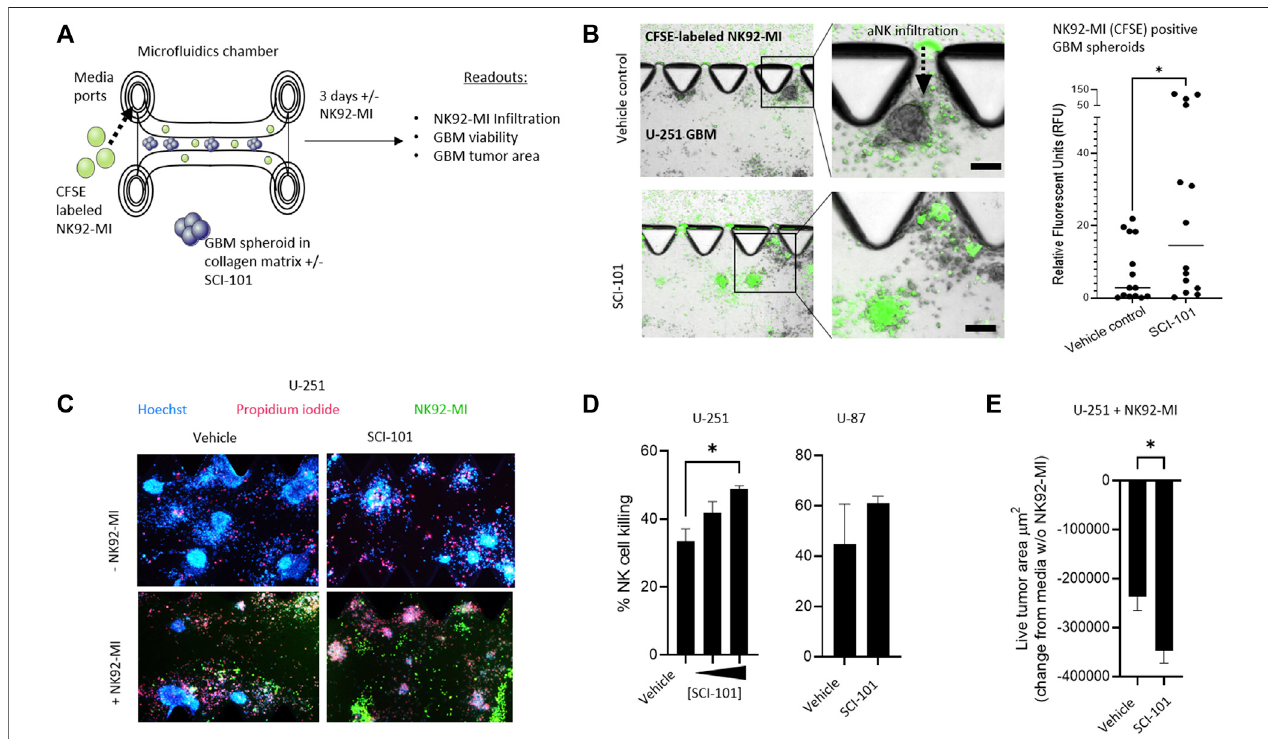
FIGURE 4 | SCI-101 increases NK92-MI tumor in fi ltration and cell killing in a 3D tumor spheroid model of GBM. (A) Micro fl uidic device and experimental design. GBM tumor spheroids are embedded in a collagen matrix and treated with SCI-101 as described in Materials and Methods . CFSE-labeled NK92-MI cells are then introduced to the media ports. Functional and quantitative readouts include in fi ltration capability of NK92-MI cells and tumor viability and growth. (B) Representative fl uorescent microscopy overlaying bright fi eld image of NK92-MI cells (green) in U-251 tumor spheroids. NK cells in fi ltrate the tumor collagen chamber as indicated by a dashed arrow. Scale bar (cid:2) 100 μ M. The right panel quanti fi es the relative fl uorescence of the CFSE signal in tumor spheroids, as described in Materials and Methods . *p < 0.05 by the unpaired t-test. (C) Representative fl uorescent microscope image of U-251 spheroids +/- SCI-101 (10 μ M) and NK92-MI (E:T 5:1). (D) (left panel)HistogramquantifyingnormalizedNKcellkillinginvehiclecontrolsandSCI-101 – treatedspheroidswith5 μ Mand10 μ